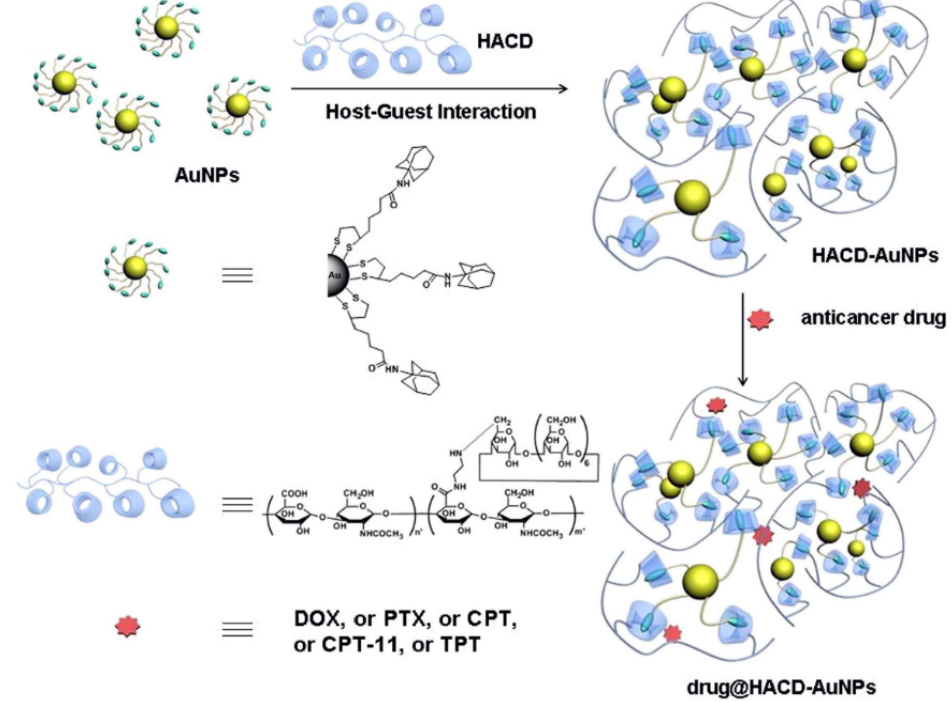
Figure 2. Schematic illustration of the chemical structures and construction of the HACD-AuNPs and the drug @HACD-AuNPs. (Adapted with permission from Ref. [25]).